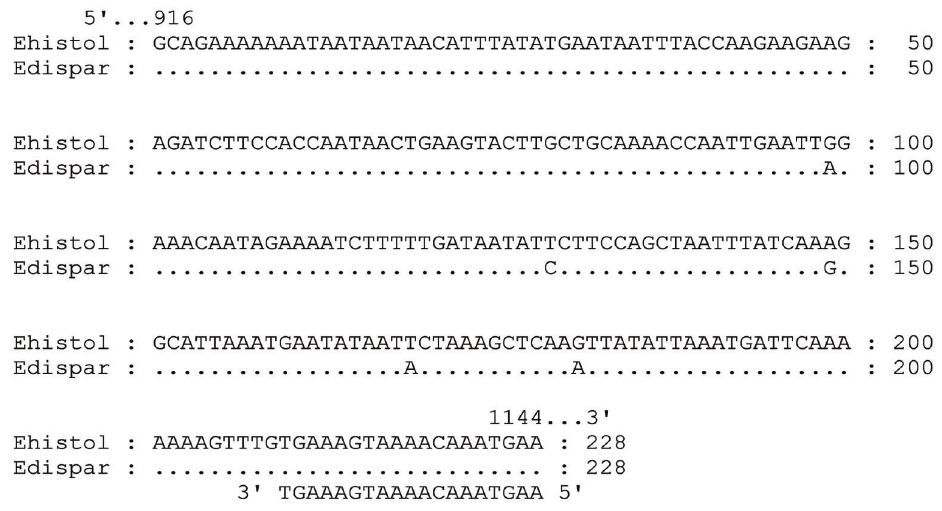
Figure 1. Alignment sequence between the adh112 gene fragments from E. histolytica and E. dispar . Five differences between sequences are highlighted.